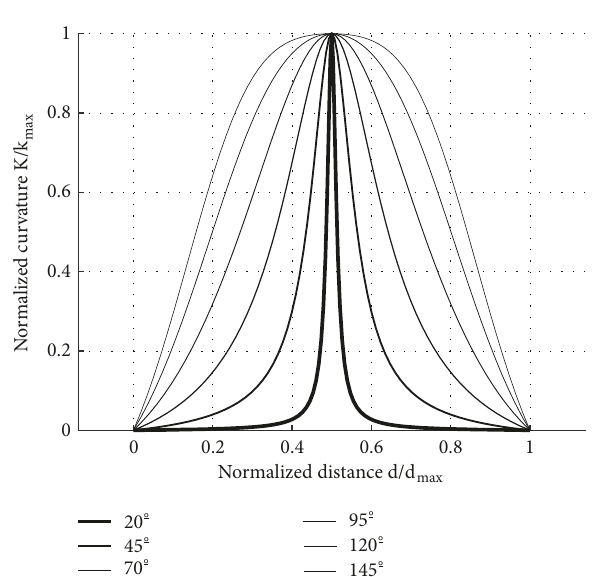
Figure 4: Curvature analysis for different intersection angles.